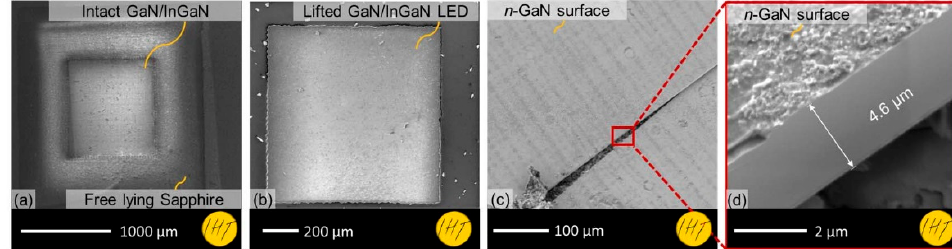
Figure 3. SEM images of a lifted LED chip. ( a ) After selective outer frame removal of the GaN layer at high pulse energy, ( b ) lifted free-standing GaN/InGaN LED chip, ( c ) closer view at the n-GaN surface condition, ( d ) cross-section at a cut through the chip.